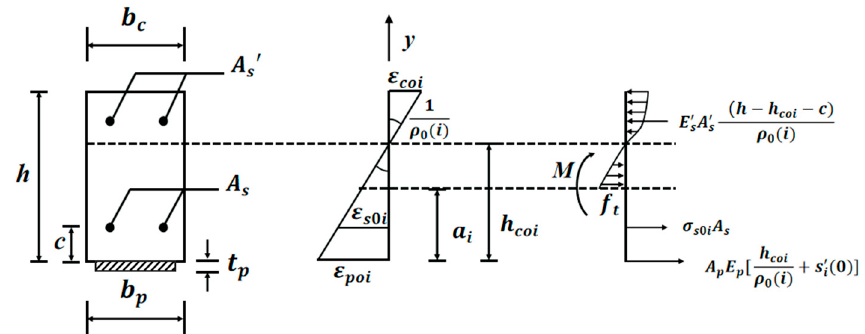
Figure 3. Distribution of stress-strain at the mid-span section.